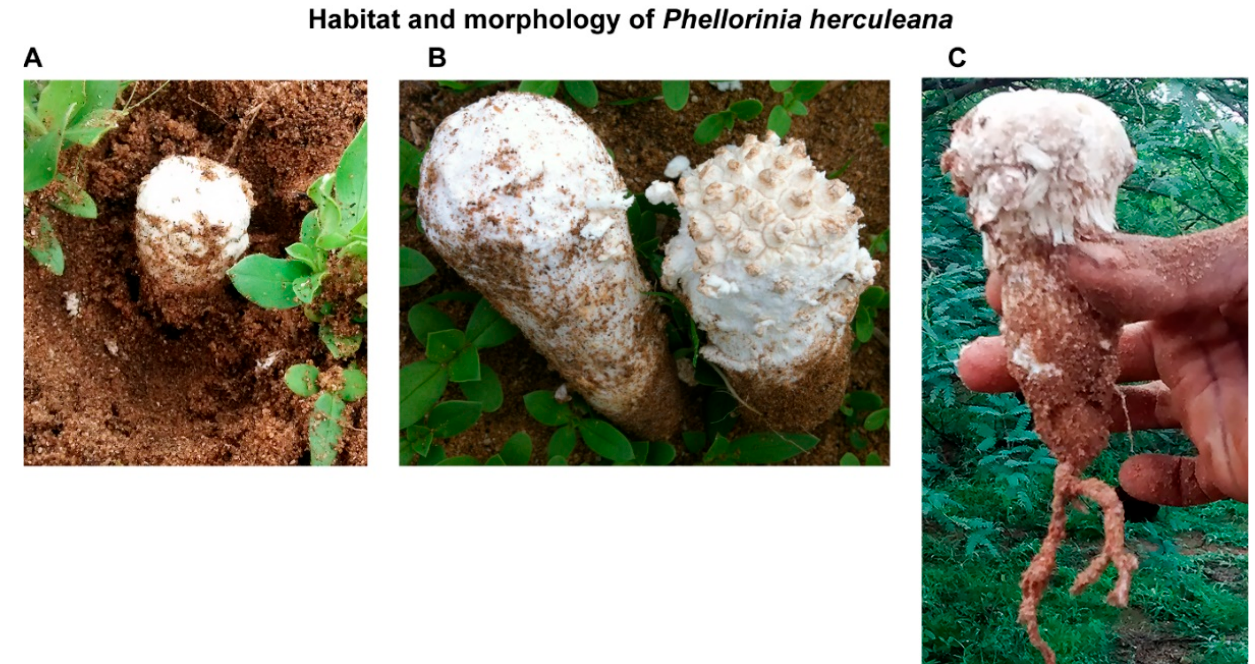
Figure 1. Habitat and morphology of Phellorinia herculeana . ( A ): Basidiocarp of P. herculeana grows sub-hypogeously in coarse sandy soil; ( B ): Pileus of P. herculeana appears as pyriform shaped; ( C ): Basidiocarp has pileus, stipe without volva and annulus and rhizoid.